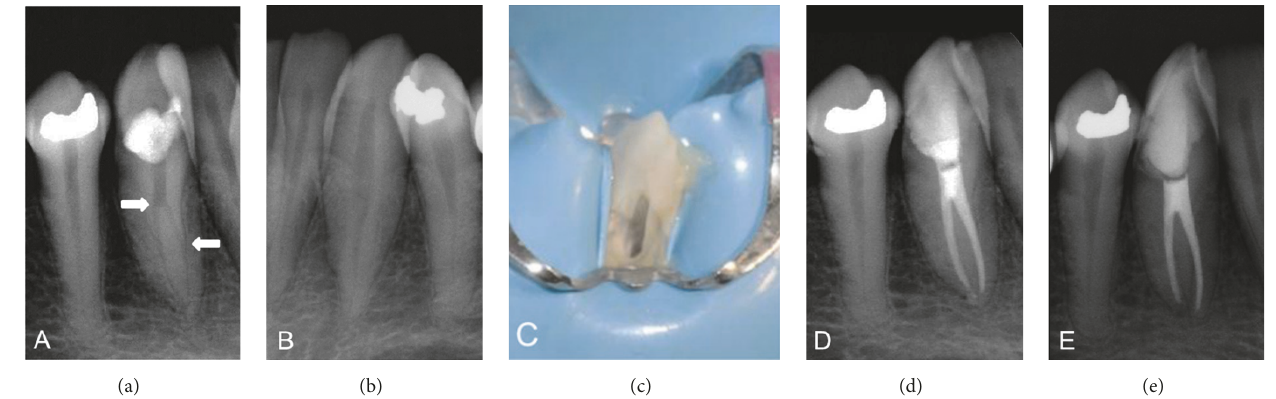
Figure 1: (a) Preoperative radiograph shows sudden loss in the continuity of the canal and the presence of a groove in the outer part of the root (arrows) . (b) Counterpart canine radiograph reveals typical root features. (c) Buccal access cavity due to dental giroversion. (d) Post-treatment radiograph. (e) 12-month follow-up radiograph shows normal periapical